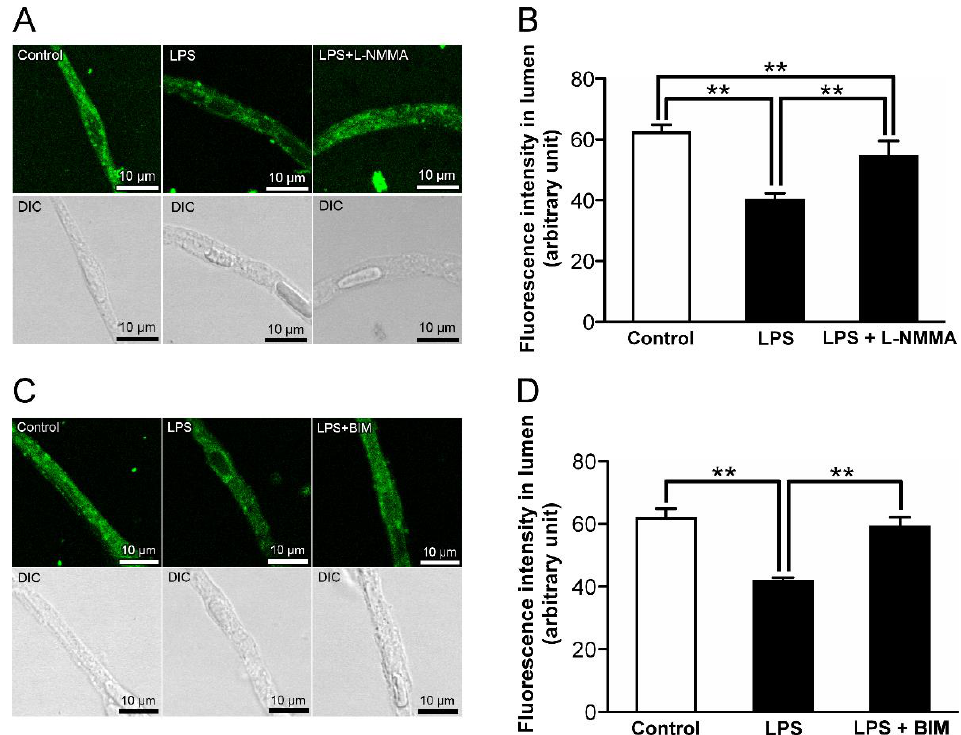
Figure 7. The effects of inhibitors for nitric oxide synthase (NOS) and protein kinase C (PKC) on the decrease in P-gp-mediated transport activity in the retinal capillaries by LPS. ( A , C ) Representative confocal images of isolated rat retinal capillaries after incubation with NBD-CSA at 4 μM for 60 min. The capillaries were preincubated with LPS at 1 ng/mL in the absence or presence of L-NMMA (NOS inhibitor) at 30 μM or BIM (PKC inhibitor) at 40 nM for 30 min. ( B , D ) Quantification of NBD-CSA fluorescence in the lumens of retinal capillaries. Each column represents the mean value for 10 capillaries from a single preparation; variability is given by S.D. bars. Units are expressed as arbi- trary fluorescence (scale 0 – 255). ** p < 0.01, significantly different between the groups. Capillary images were captured using a TCS-SP5.